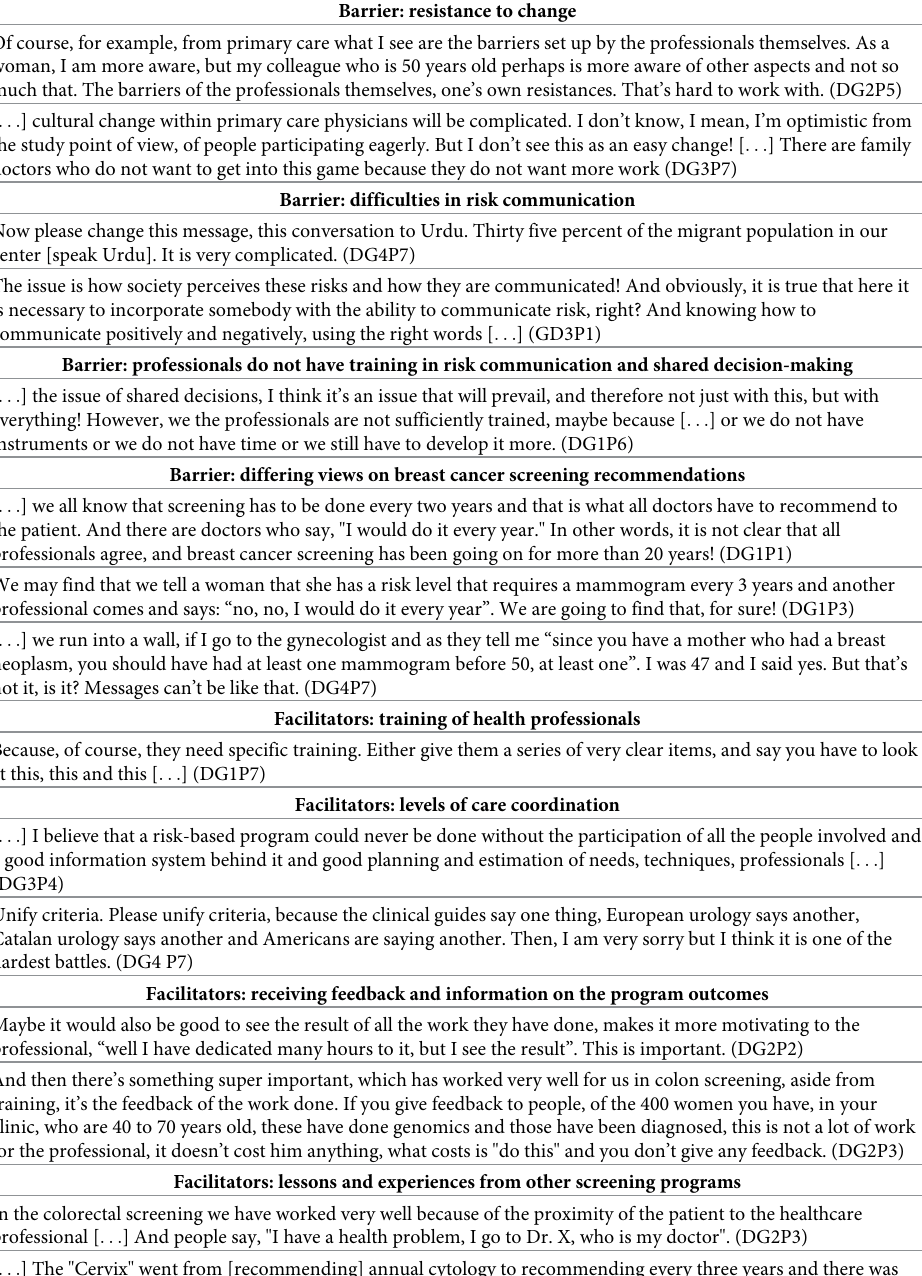
Table 3. Selected quotes from health professionals’ discussion groups on barriers and facilitators for health pro- fessionals related to participating in risk-based screening. Barrier: resistance to